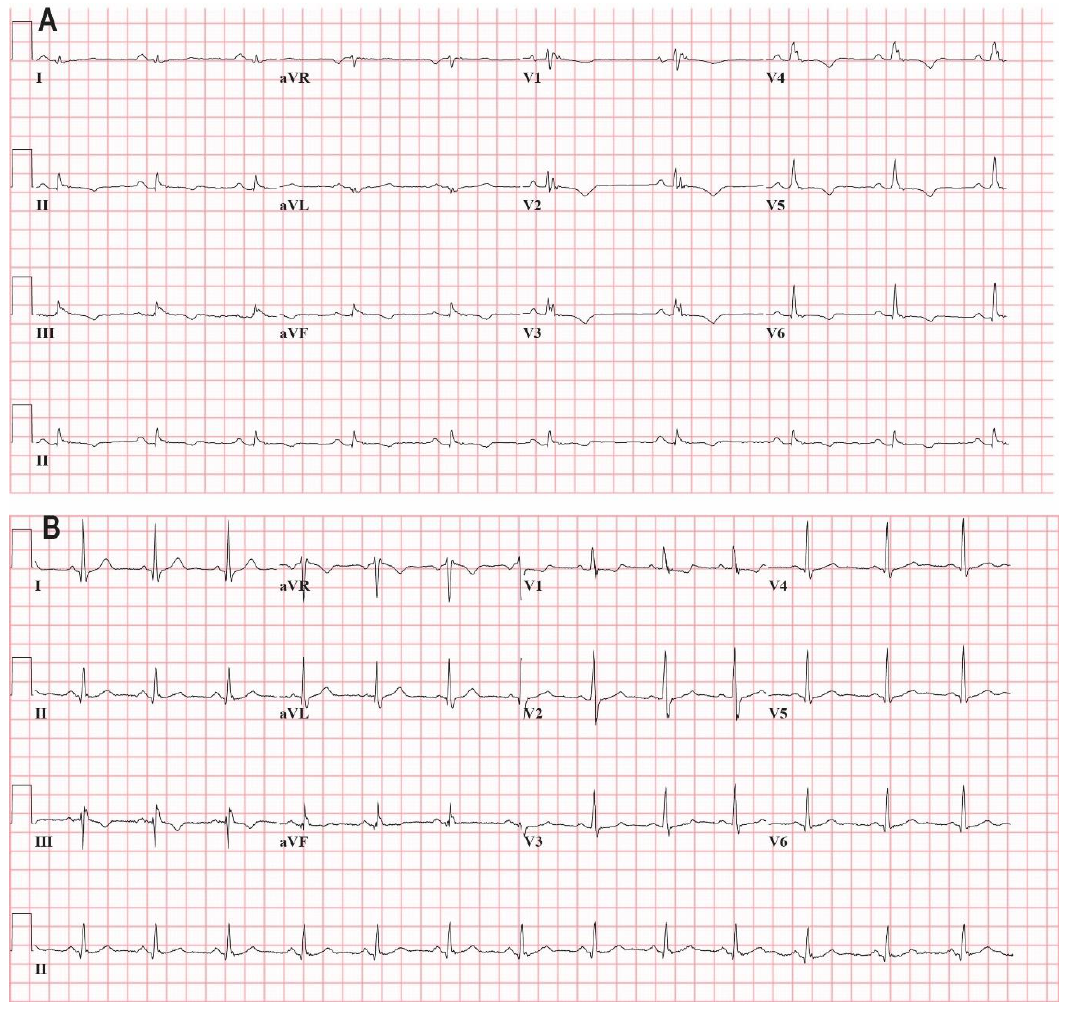
Figure 1. ( A ): Resting electrocardiography (ECG) (25 mm/s, 10 mm/mV, 150 Hz) of a 43 year